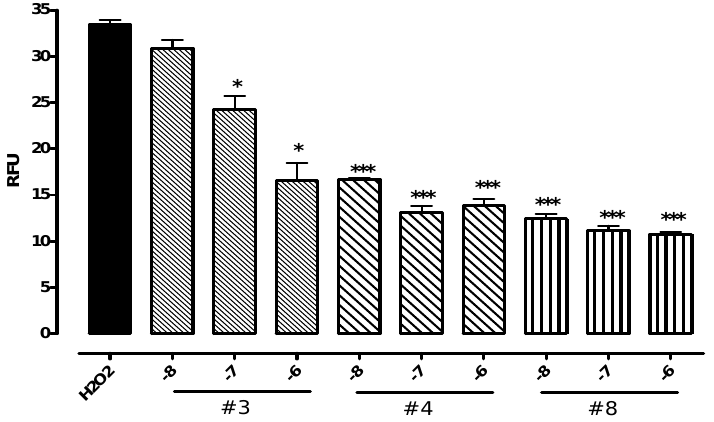
Figure 1. Effect of compounds 3 , 4 and 8 on ROS production in J774.A1 macrophages.